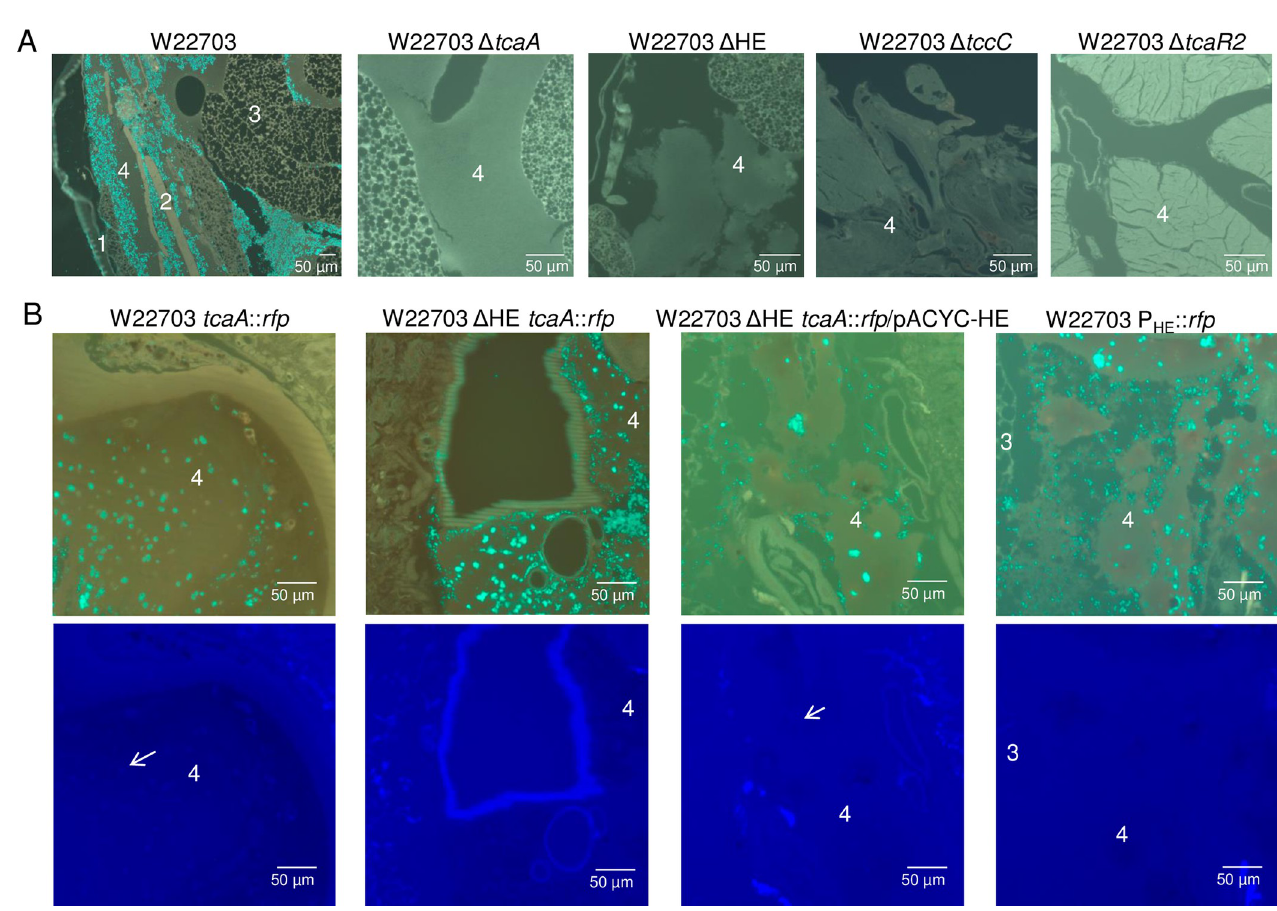
Fig 6. Detection of W22703 and its derivatives in the hemolymph of G . mellonella . All photos show the hemolymph area of G . mellonella . (A) G . mellonella tissue sections 24 h p.i. with W22703 and its mutants. Staining was conducted using the anti- Yersinia antibody. (B) Tissue sections of larvae 24 h p.i. with W22703 tcaA :: rfp , W22703 Δ HE tcaA :: rfp , W22703 P HE :: rfp , and W22703 Δ HE tcaA :: rfp /pACYC HE. Staining was performed with the Yersinia -specific antibody (top row) or the anti-RFP antibody (bottom row), which was applied to the same tissue sections, to detect TcaA production as indicated exemplarily by arrows. Preparations of ten infected animals per strain were carried out. Photos of representative preparations are shown; the scales are indicated. 1 = exoskeleton, 2 = musculature, 3 = fat tissue, 4 = hemolymph.